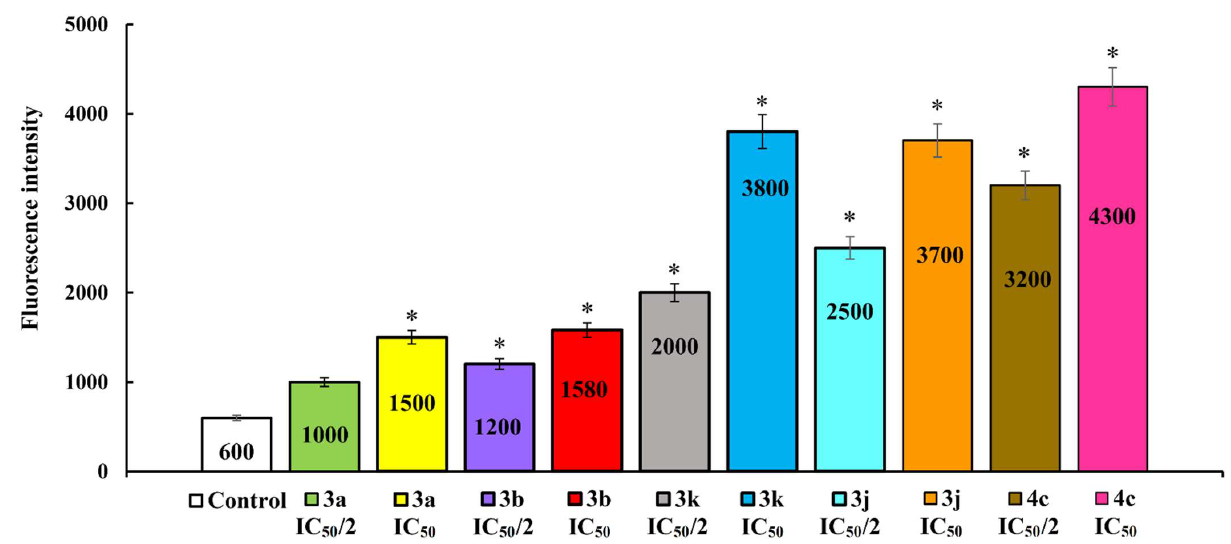
Figure 6. Quantitative determination of % cells with red aggregates.